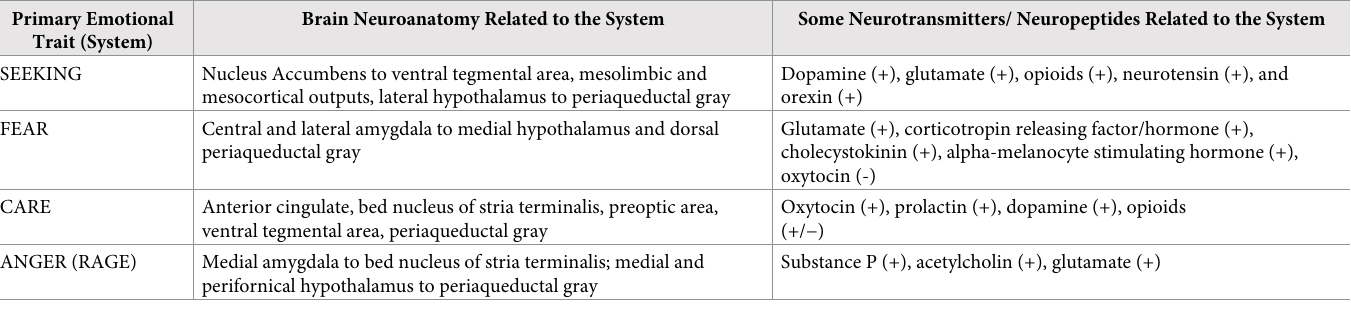
Table 3. Primary emotional traits/systems and their brain neuroanatomy and neurotransmitters/neuropeptides. Primary Emotional Brain Neuroanatomy Related to the System Some Neurotransmitters/ Neuropeptides Related to the Trait (System)